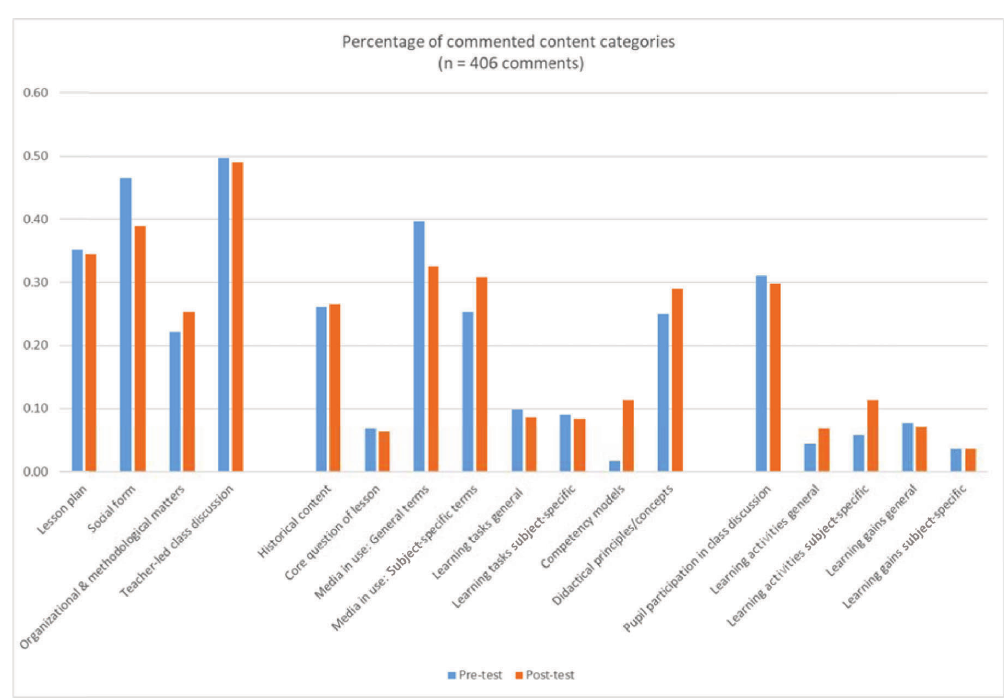
Figure 1: Percentage of commented content categories within the 406 pre-service teachers’